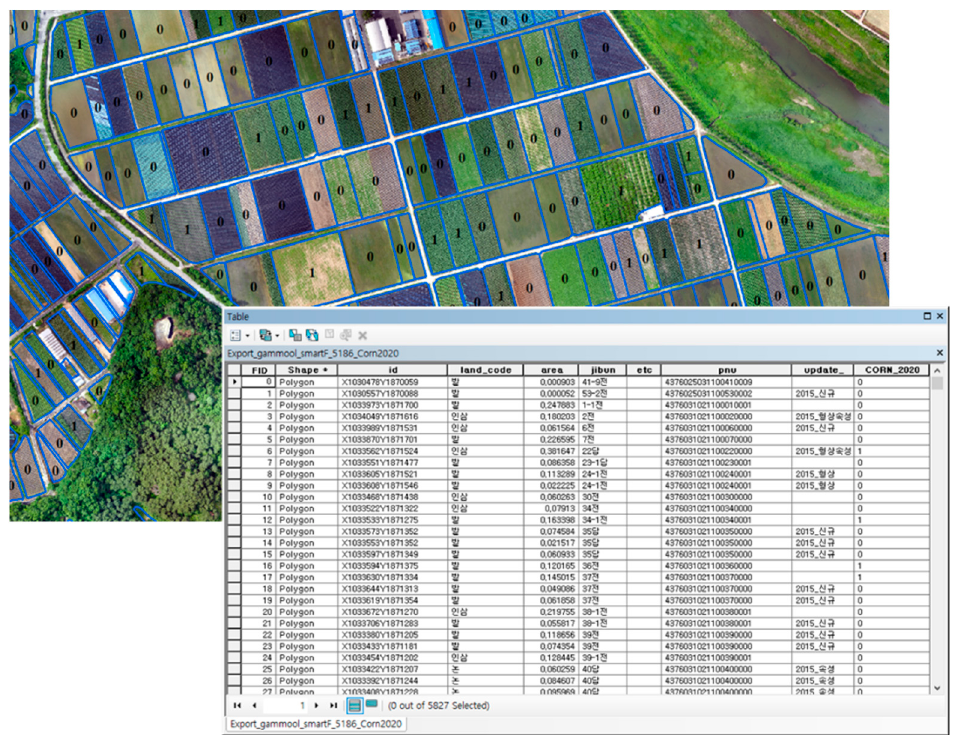
Figure 7. The classification of corn cultivation areas used for field surveys after overlapping ArcGIS and Farm Map. Numbers in the figure are coded as 1 for corn-growing fields and 0 for other fields.